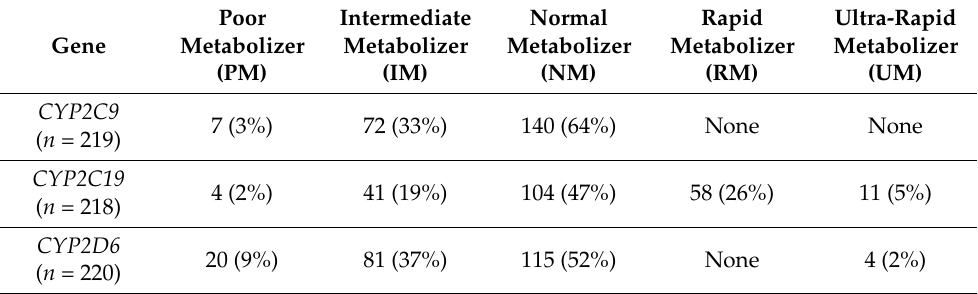
Table 3. Number of breast cancer patients (%) predicted to exhibit variant metabolic phenotypes for common pharmacogenes involved in drug